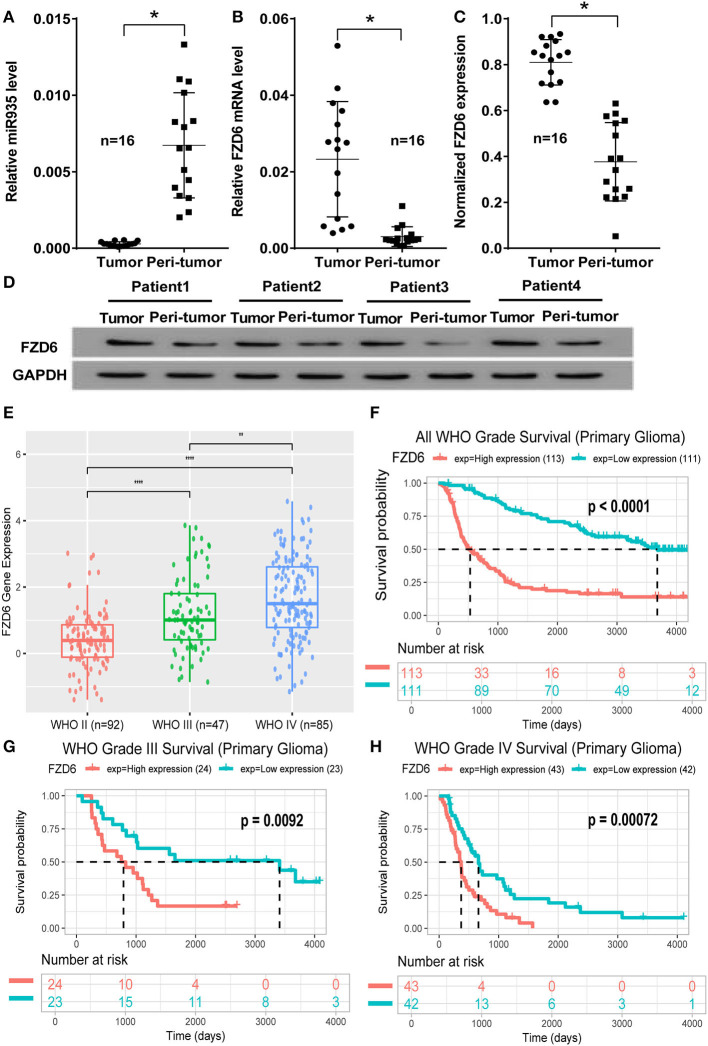
Clinical feature of the miR-935/FZD6 axis in human glioma tissues. (A) The miR-935 expression in human glioma tissues (tumor) and paired normal tissue adjacent to tumors (peri-tumor) (n =16). (B) The expression of FZD6 mRNA in human glioma tissues (tumor) and paired normal tissue adjacent to tumors (peri-tumor) (n = 16). (C) Data plotting shows the expression of FZD6 in human glioma tumor tissues (tumor) when comparing paired normal tissue adjacent to tumors (peri-tumor) (n =16); *p < 0.05 between the indicated groups and the unpaired Student's t-test. (D) Representative western blotting of FZD6 expression in four out of 16 patients with glioma. (E) The expression of FZD6 in the mRNAseq_325 dataset of the CGGA database, classified by WHO grades II, III and IV; ****p < 0.0001, **p < 0.01, when compared between the indicated groups. The differential overall survival probability between the higher or lower FZD 6 expression, divided by median, in all WHO grades (F), WHO grade III (G), and WHO grade IV (H) patients were presented by the Kaplan–Meier curve.